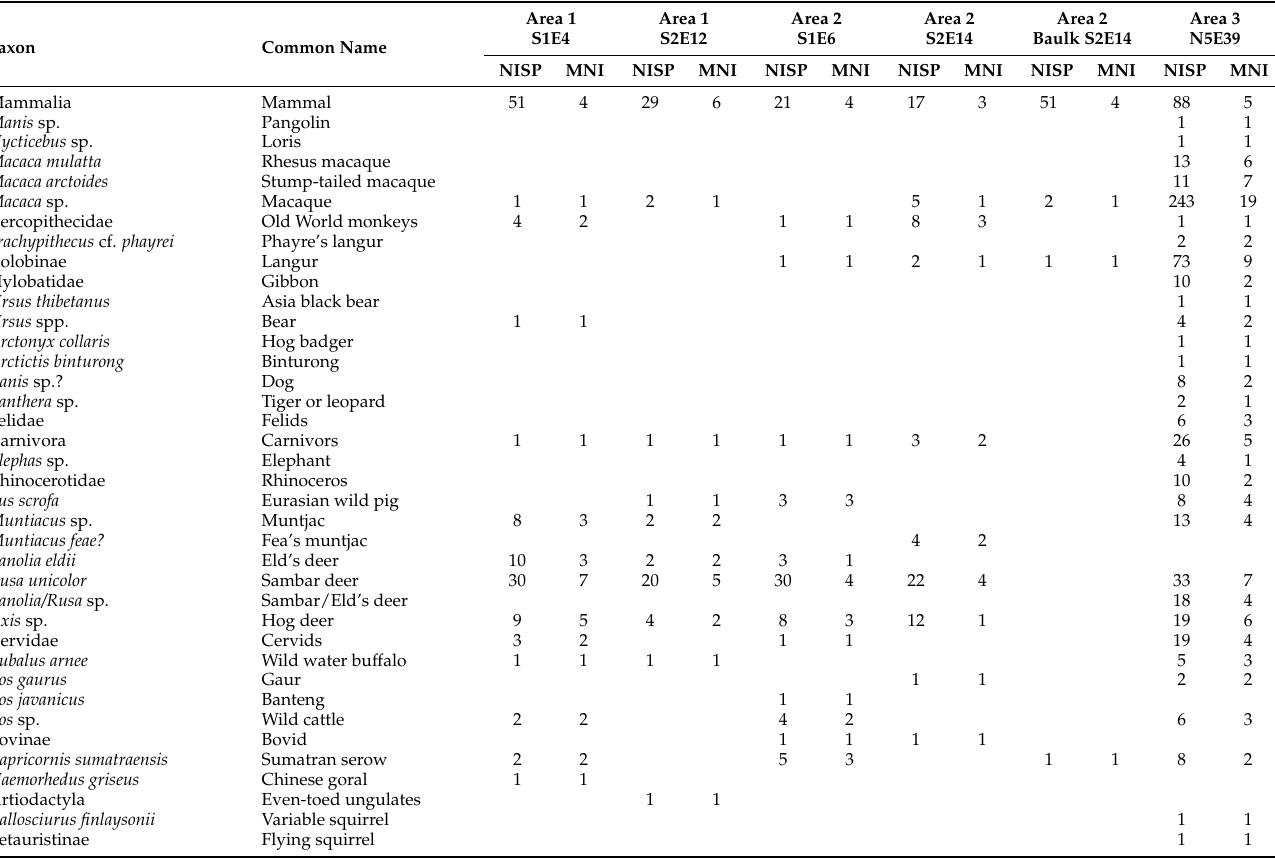
Table 2. Summary of identified taxa in the Ban Rai Rockshelter zooarchaeological assemblage. Area 1 includes Layers 2–4 of both S1E4 and S2E12. Area 2 includes only Layer 4 of pit S1E6, S2E14, and Baulk S2E14. Finally, Area 3 includes Layers 3, 4, 5, and 6 of pit N5E39. Taxonomic abundance listed as the number of identified specimens (NISP) followed by the minimum number of individuals (MNI); additional data in Supplementary Tables S1–S3.